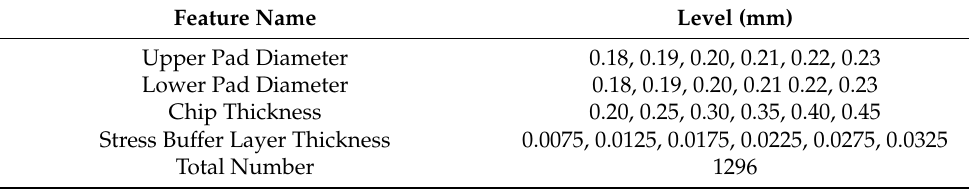
Table 7. Training data 1296 of FEM for four input features.